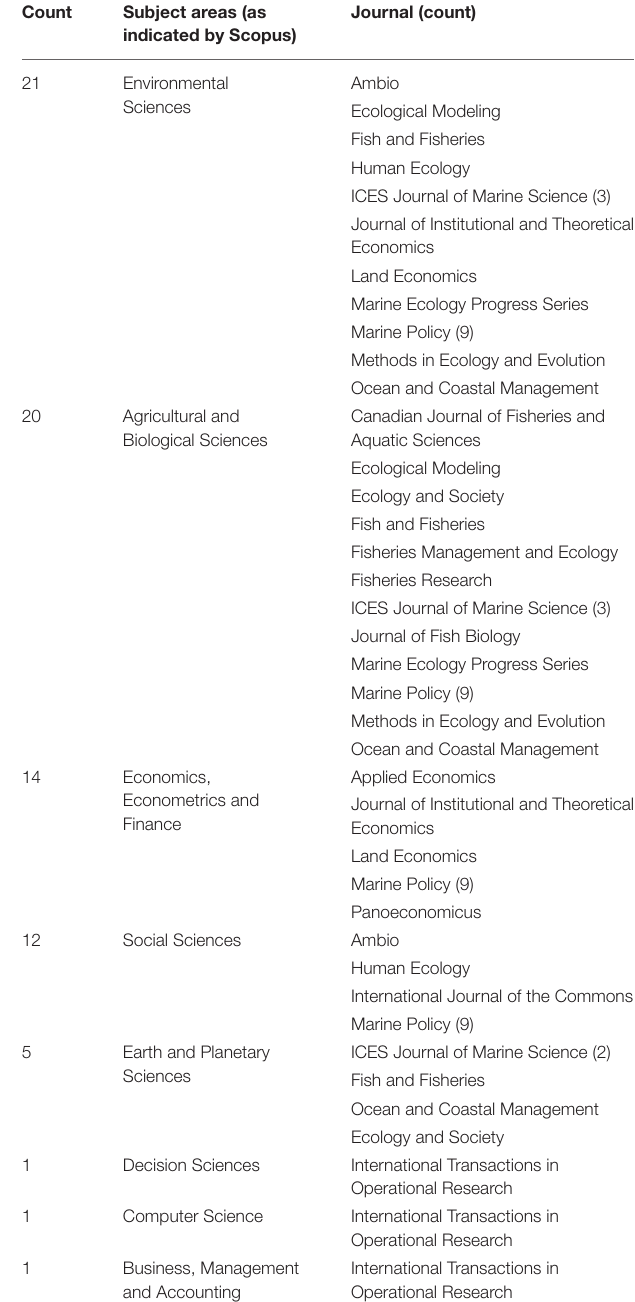
TABLE 2 | The subject areas and corresponding journals identified in this study. Count Subject areas (as indicated by